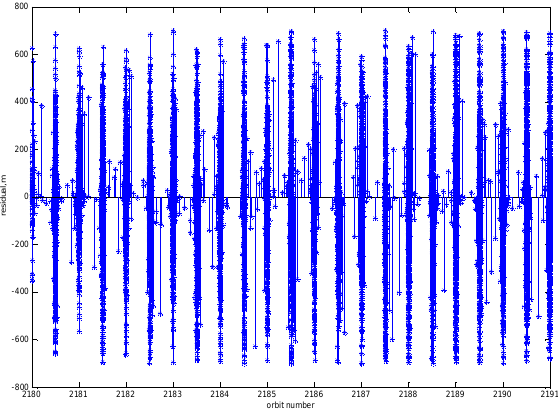
Figure 3. Crossover difference versus time over one earth day